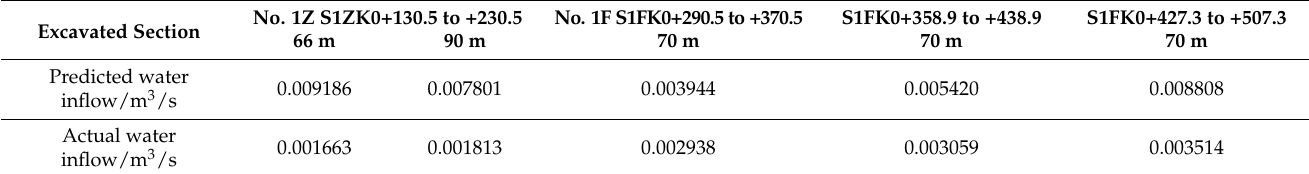
Table 26. Different excavation sections with predicted and measured water inflow.